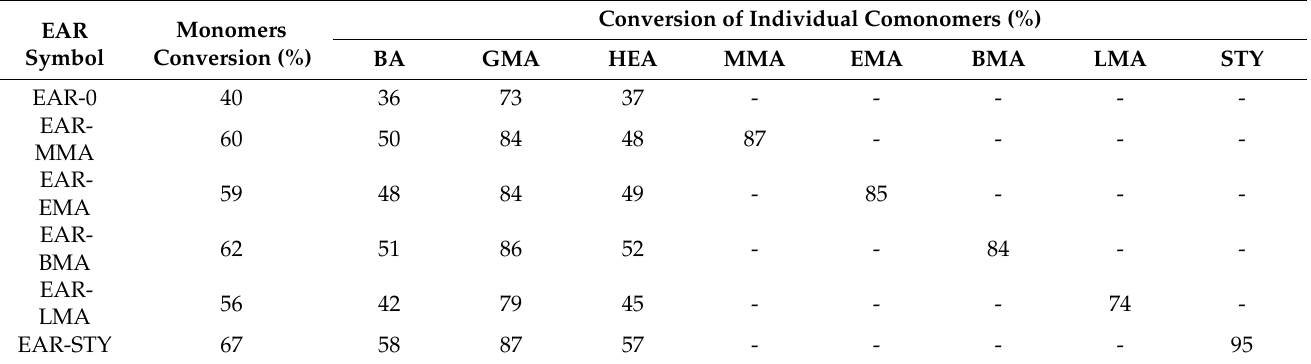
Table 4. Monomers’ conversion calculated by proton nuclear magnetic resonance ( 1 H NMR)